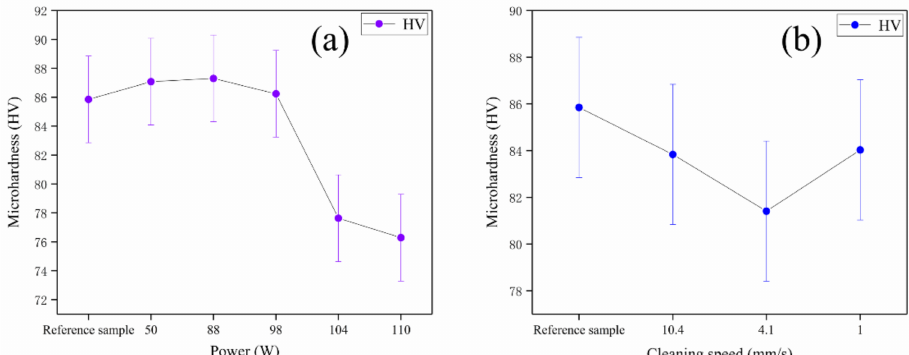
Figure 11. ( a ) Surface microhardness of aluminum alloy after laser cleaning under di ff erent powers; ( b ) surface microhardness of aluminum alloy after laser cleaning at di ff erent speeds.